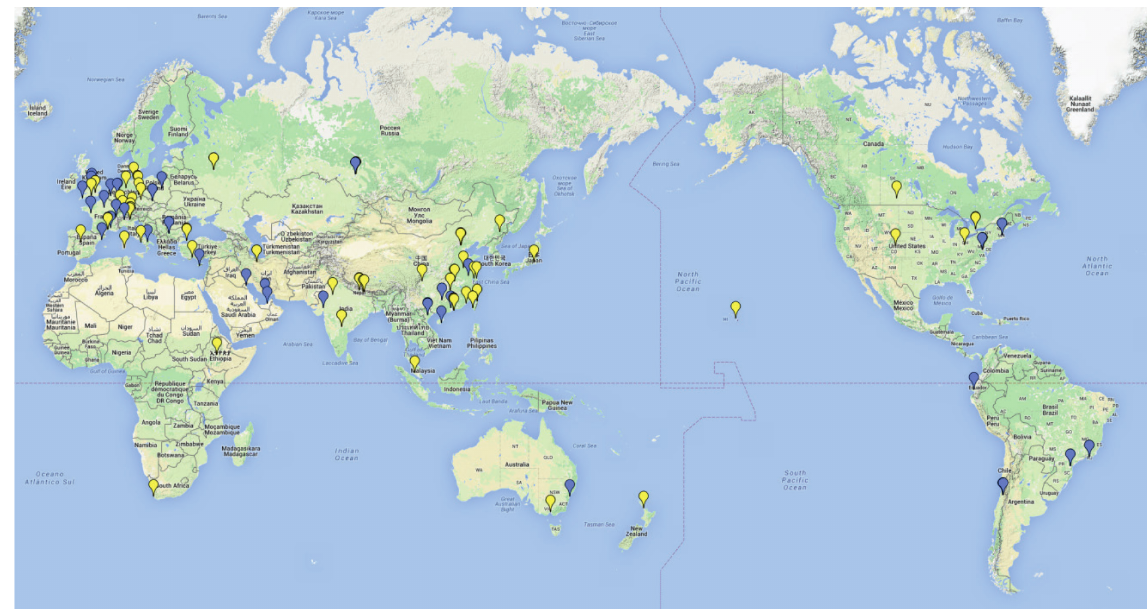
Figure 1: ISPRS events (yellow) and ISPRS co-sponsored events (blue) organised during 2012 - 2016 across the